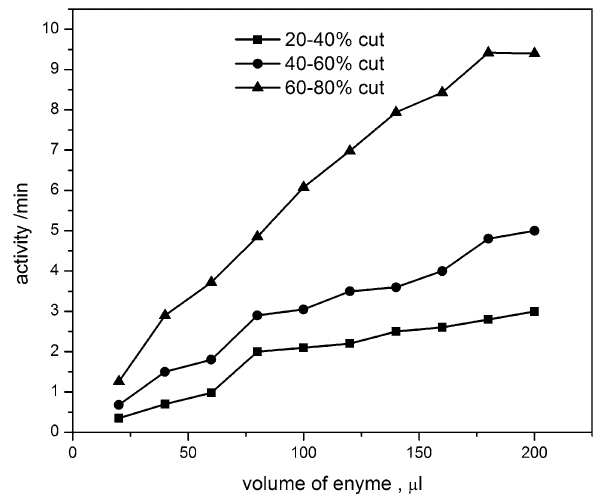
Fig. 4 Optimization of cuts and enzyme volume for baby corn husk